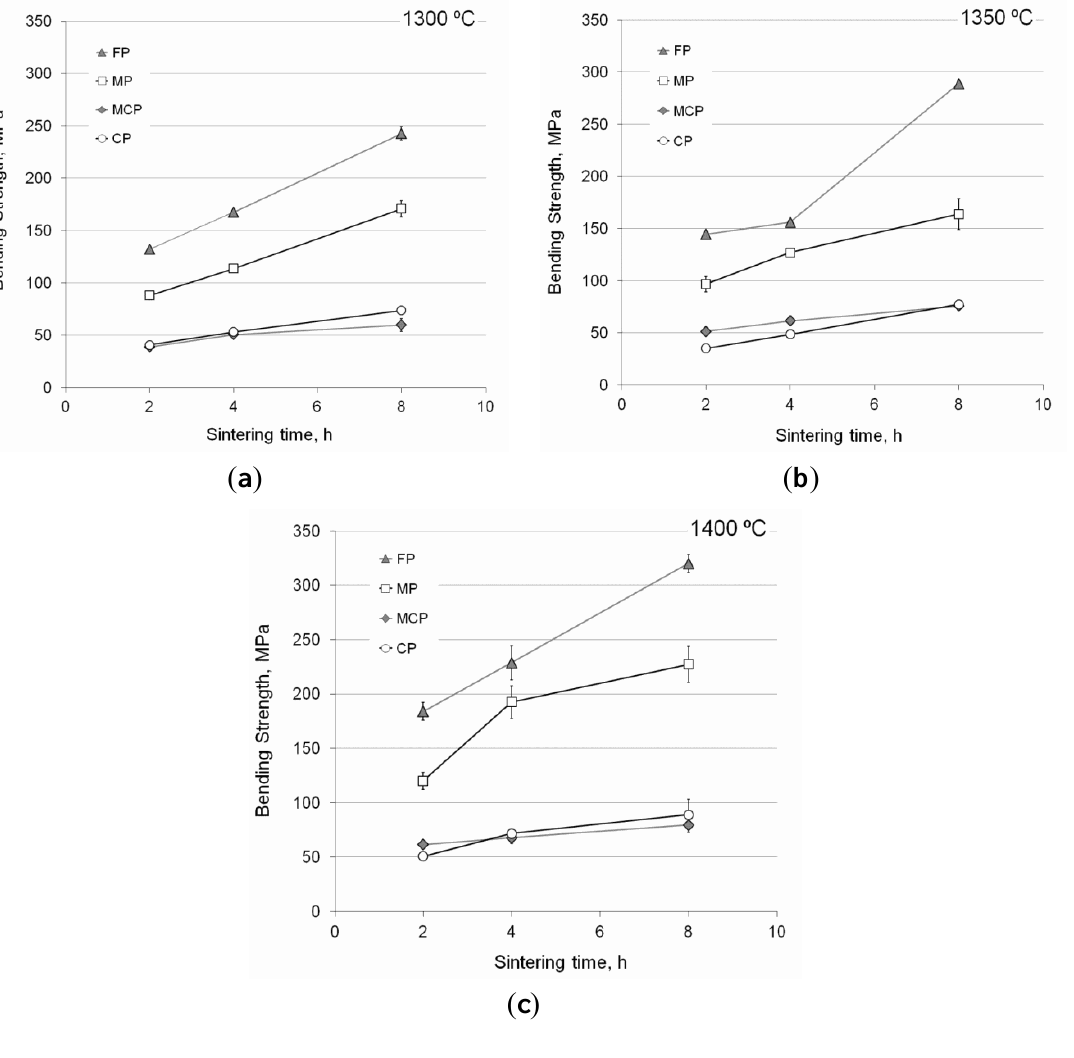
Figure 5. Bending strength and standard deviation of the porous samples developed